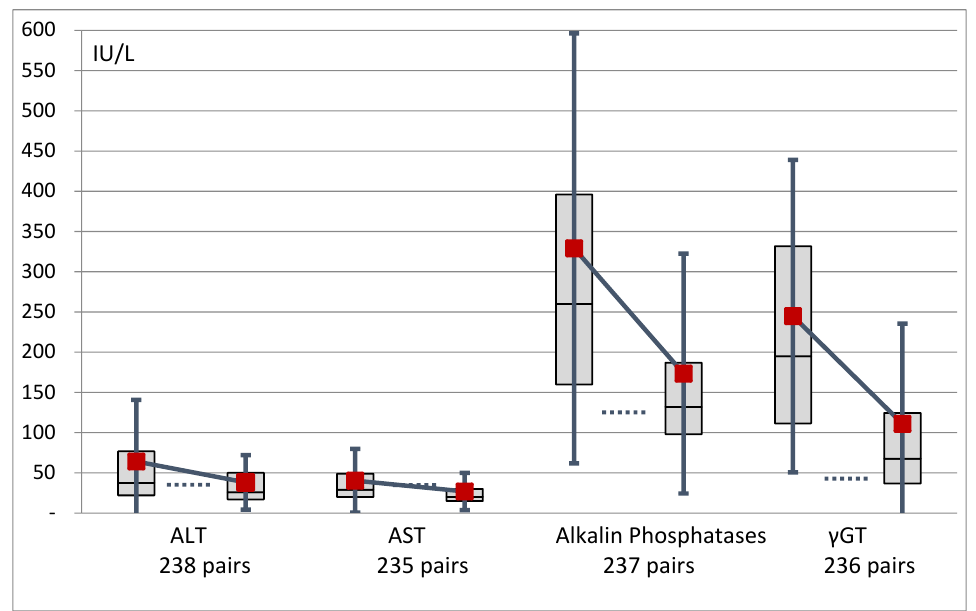
Figure 5. Evolution of liver tests expressed as their international units. The dashed horizontal bars represent the upper values of the normal for each data pair. p < 0.0001 for all. ALT: alanine aminotransferase; AST: aspartate aminotransferase; γGT: γ-glutamyltransferase. Median delay (quartile 25–75%) between the initial surgery and admission in our center was 31 (19–7) days. CR began five (2–10) days after admission and lasted 64 (45–94) days, max 272 days. The